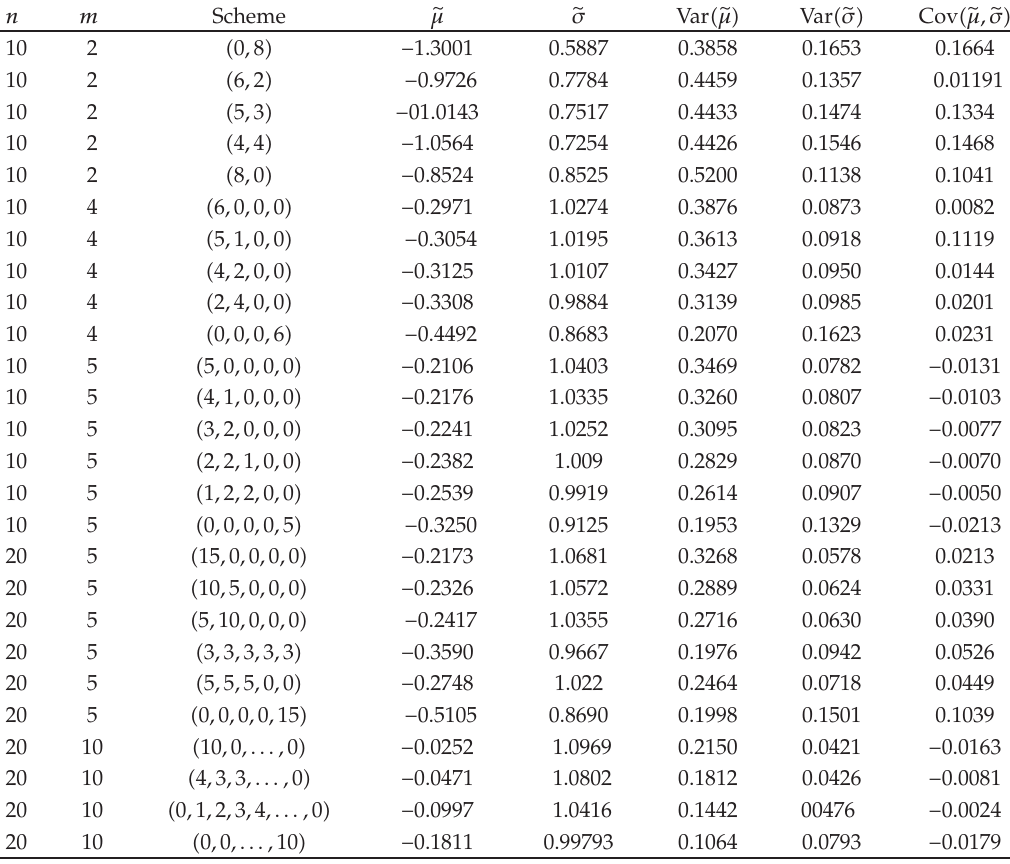
Table 7: Average, variances, and covariance of the approximate MLEs when the shape parameter φ (cid:7) 2. n